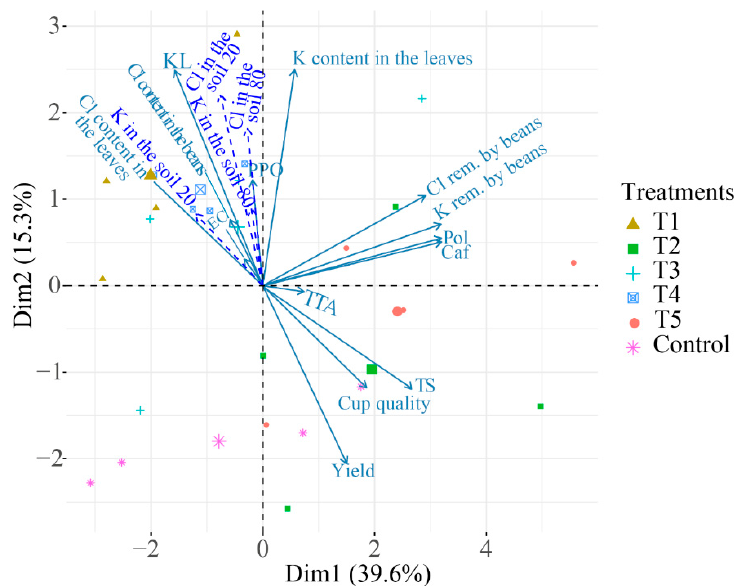
Figure 9. Principal component analysis for the harvest of 2018/2019. PPO = activity of the enzyme polyphenol oxidase; KL = K leaching; TTA = total titratable acidity; EC = electric conductivity; Pol = total phenolic compounds; Caf = content of caffeine; TS = content of total sugars; K in the soil 20 = stock of K in the 0–20 cm layer; K in the soil 80 = stock of K in the 20–80 cm layer; Cl in the soil 20 = stock of Cl in the 0–20 cm layer; Cl in the soil 80 = stock of Cl in the 20–80 cm layer, K rem. by beans: K removal by the beans, Cl rem. by beans: Cl removal by the beans. T1: 100% KCl, T2: 75% KCl + 25% K 2 SO 4 , T3: 50% KCl + 50% K 2 SO 4 , T4: 25% KCl + 75% K 2 SO 4 , T5: 100% K 2 SO 4 .